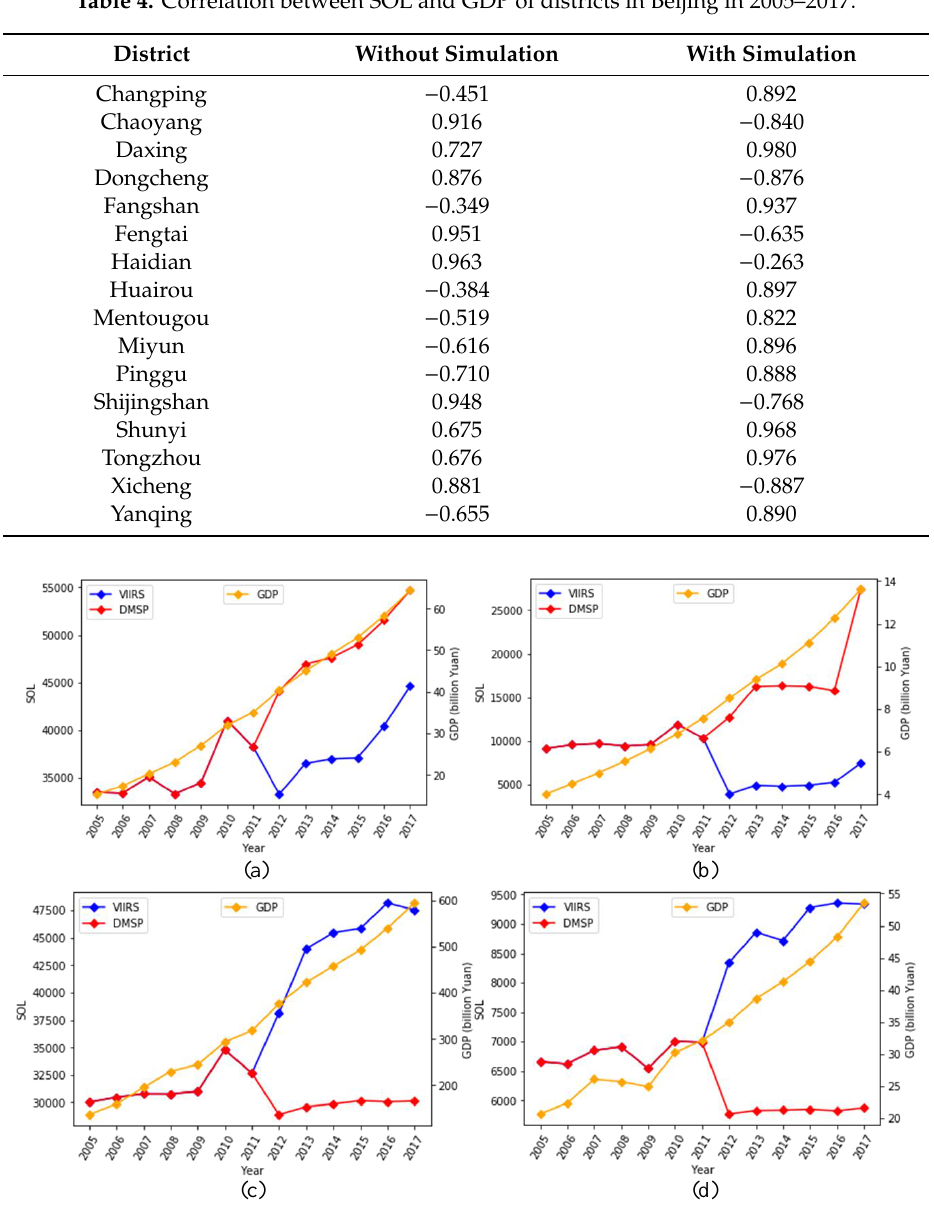
Figure 12. SOL of NTL and GDP of Districts Daxing ( a ), Yanqing ( b ), Haidian ( c ) and Shijingshan ( d ) in